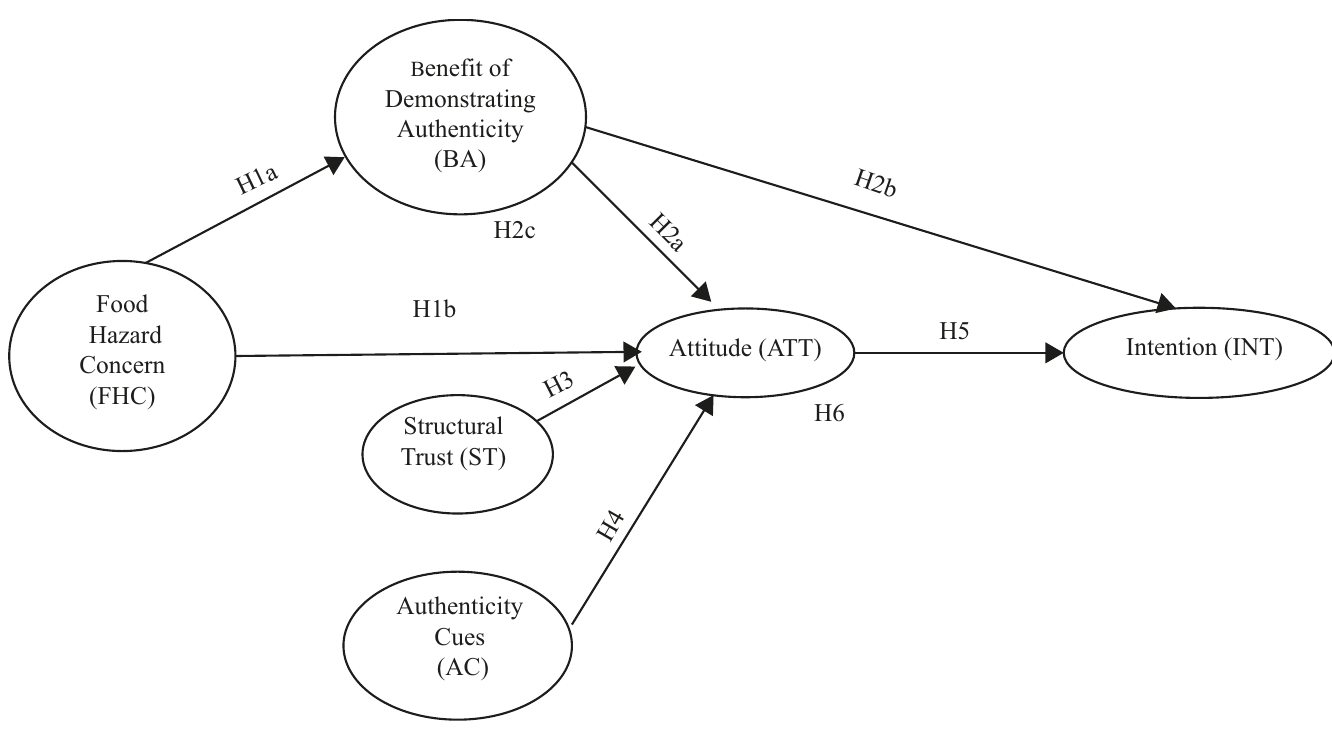
Fig 1. Conceptual